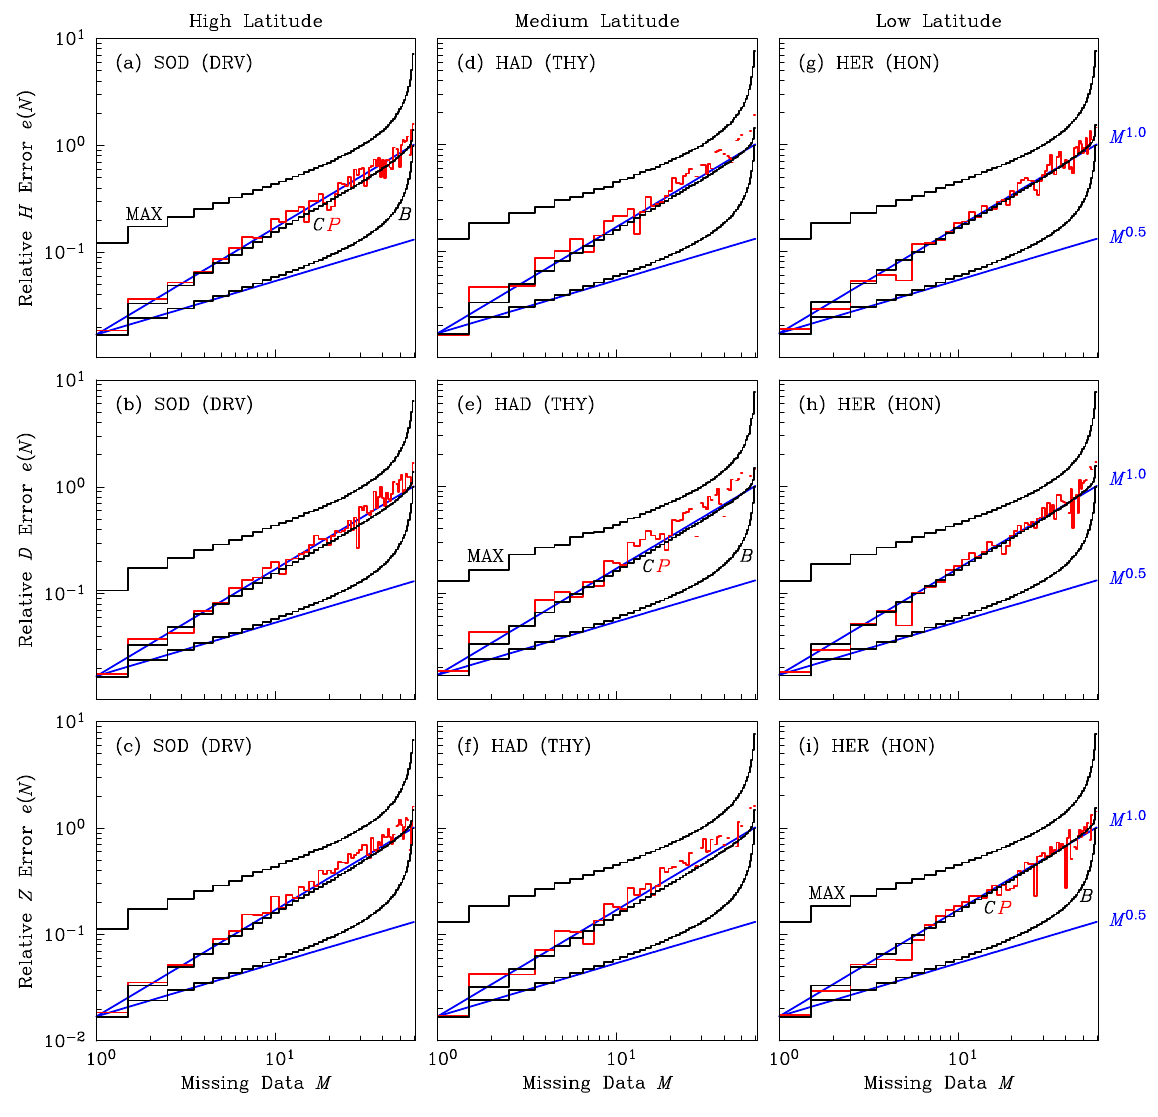
Fig. 5. Root-mean-square RMS and maximum MAX relative error results e(N) for (a–c) H , D , and Z magnetic-vector components for high- latitude observatories SOD (DRV), (d–f) medium-latitude observatories HAD (THY), (g–i) low-latitude observatories HER (HON), each as a function of number of missing data M . (B,C,P) denotes results for (binomial, continuous, proxy) gap distributions. For comparison, fits proportional to M and M 1 / 2 are also shown. No proxy result is calculated when 3 or fewer proxy instances are